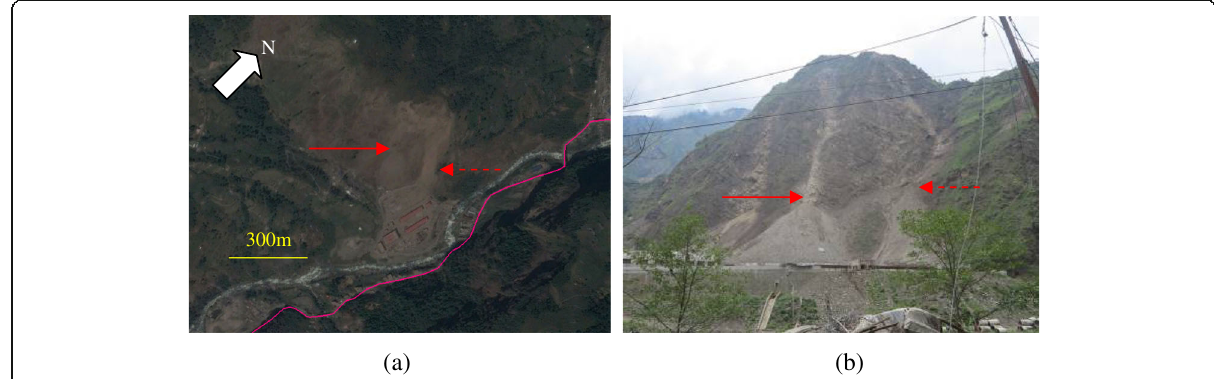
Fig. 4 Rockfalls on the upper slope of an inspection station of Nepal. a Satellite image of 4 May 2015. b Field photo of 14 June 2015 (by Chong Xu, view to northwest). The solid and dotted arrows in ( a ) and ( b ) indicate the same places,